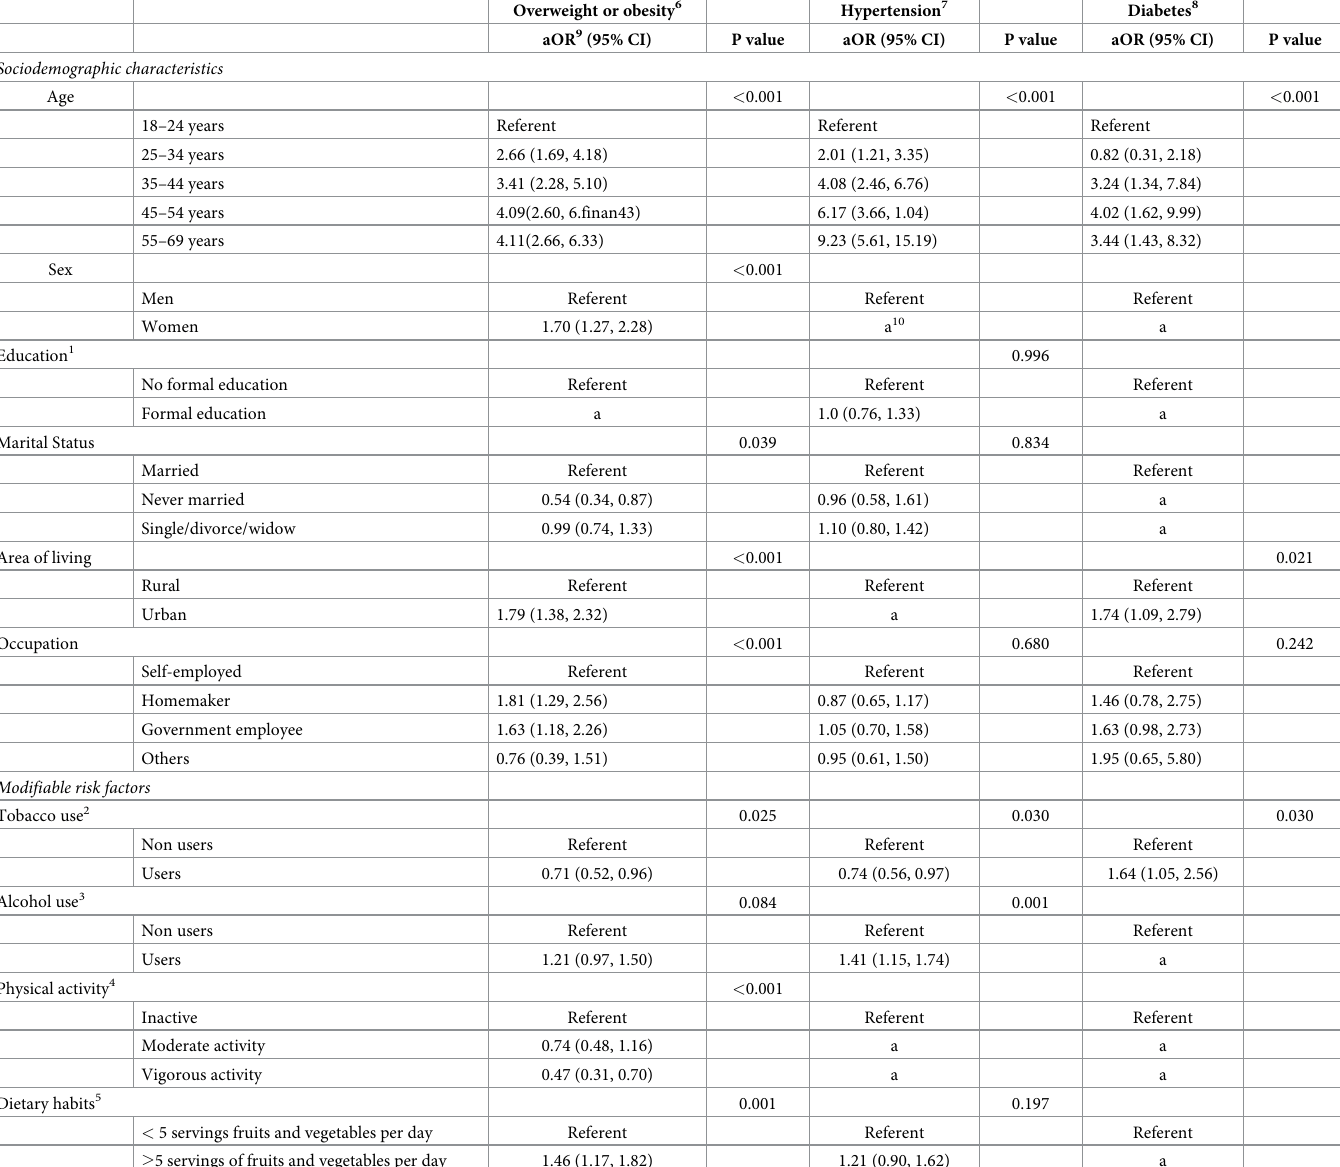
Table 3. Independent risk factors for overweight or obesity, hypertension or diabetes using multiple logistic regression